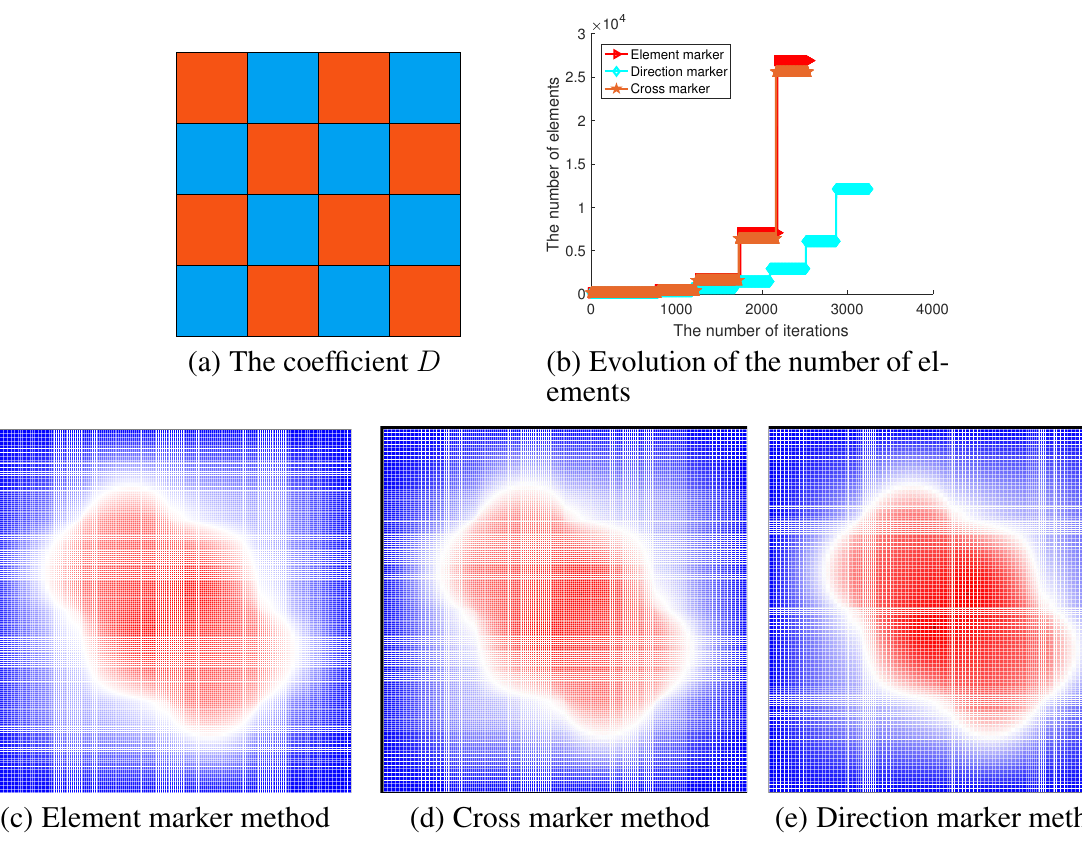
Figure 1: The diffusion coefficient, the evolution of the total number of element during the splitting algorithm and the discrete solution φ